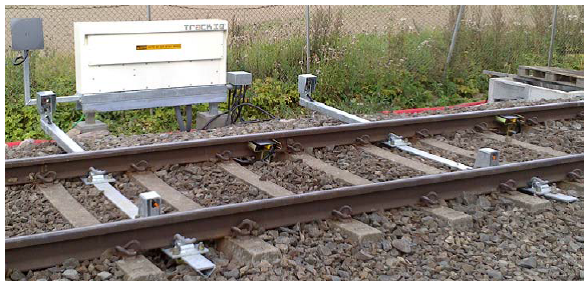
Figure 1: Fixed trackside RFID configuration.